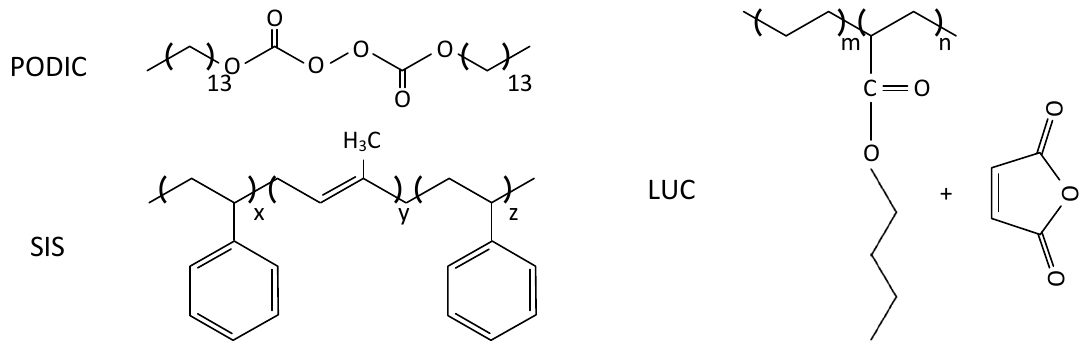
Figure 2. Chemical structures of the added